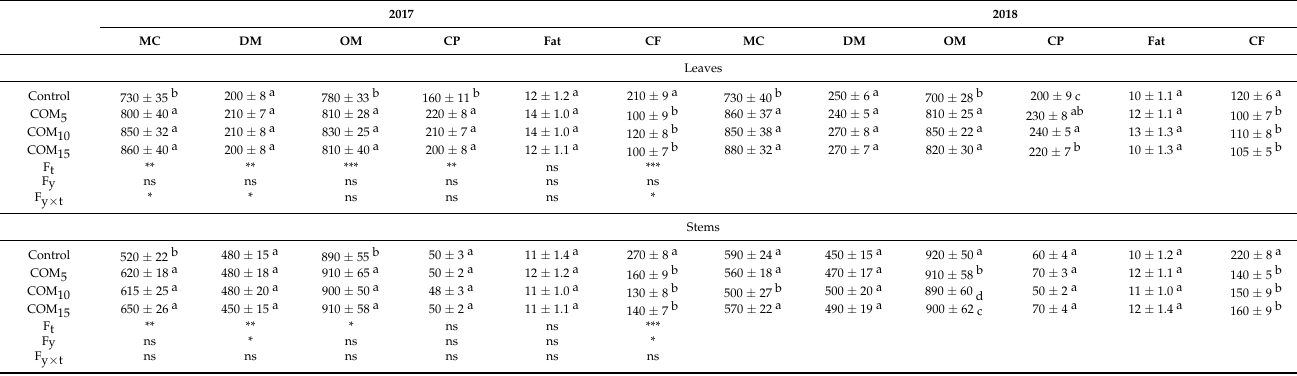
Table 5. Effect of compost treatments on the chemical composition of leaves and stems of river saltbush plants (g kg − 1